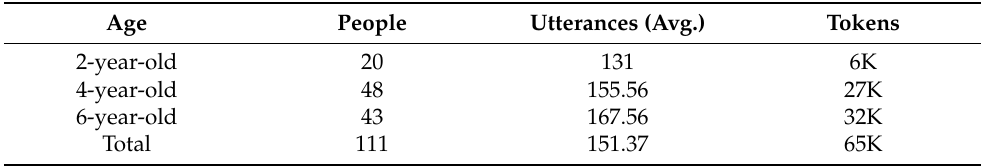
Table 2. Example of transcription about 2-year-old child.